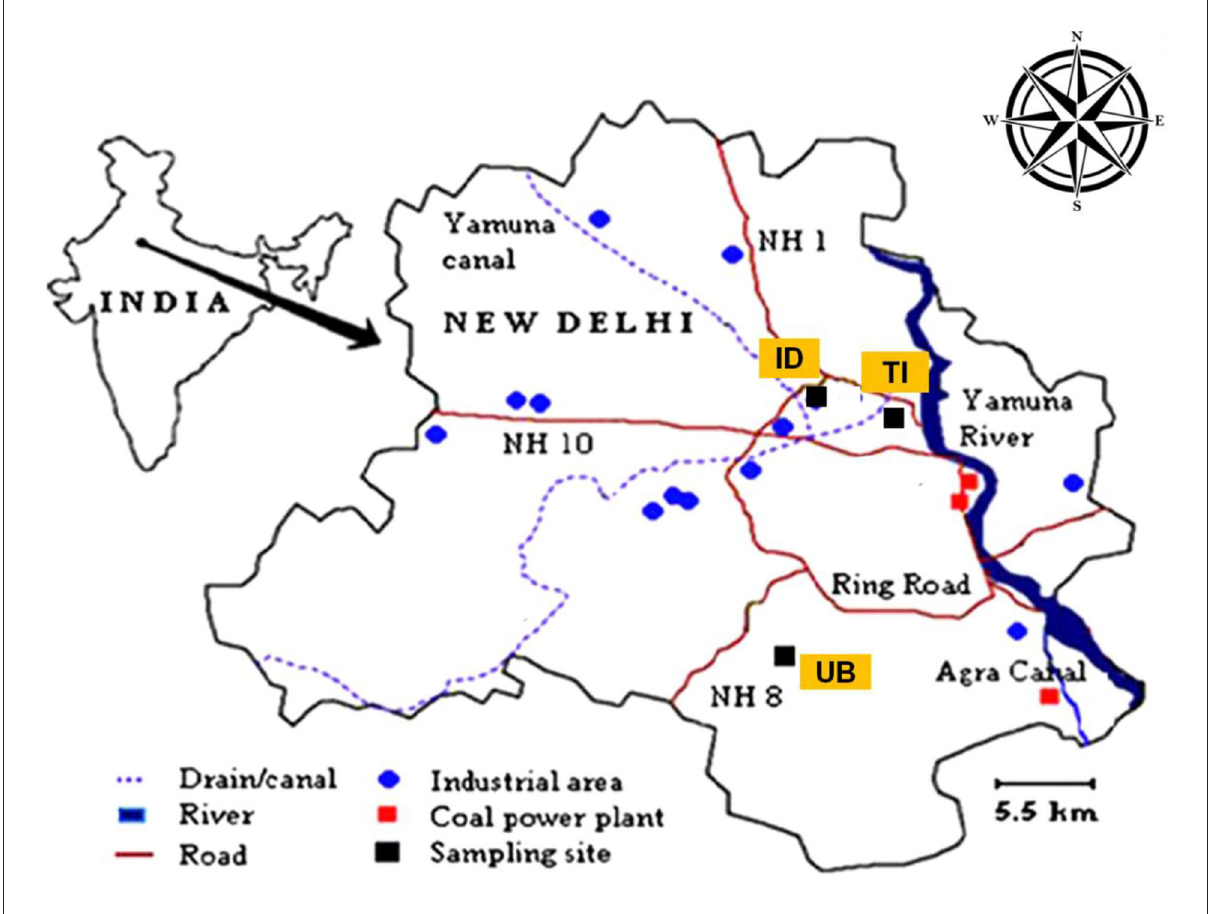
FIGURE1 Map showing study sites in